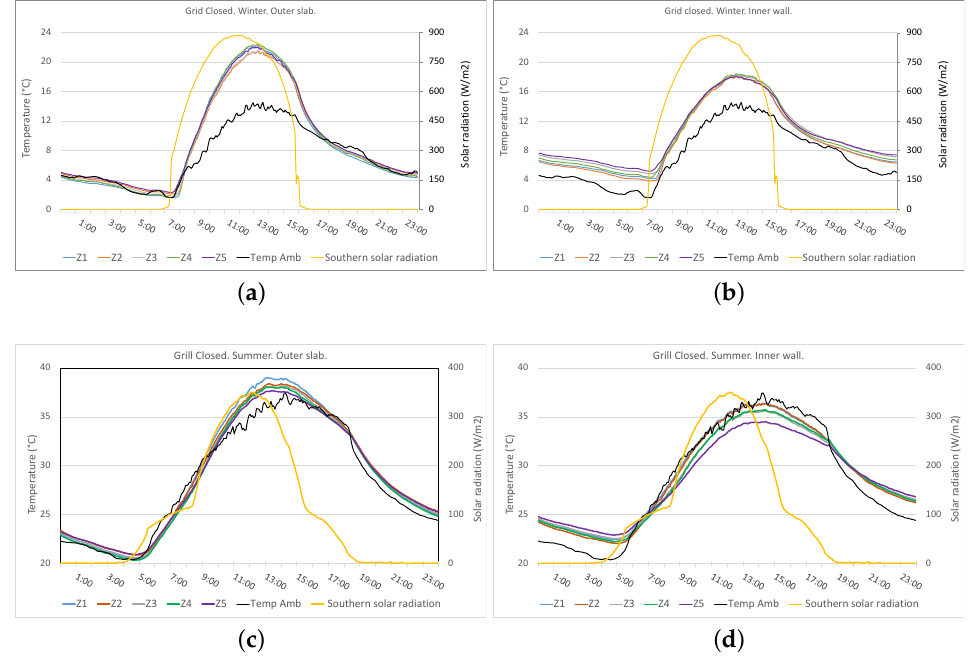
Figure 15. Closed ventilation grills. Evolution of the measured temperatures of the surfaces in the air cavity for: a winter day (3 January 2021), ( a ) exterior slab, ( b ) inner wall; a summer day (24 June 2021), ( c ) exterior slab, ( d ) inner wall. South solar radiation and ambient temperatures are